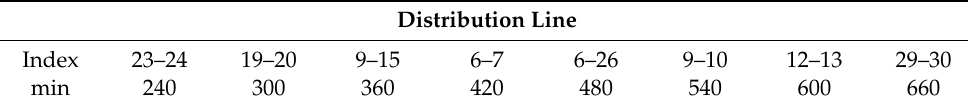
Figure 4. The situation of damaged lines for the test system. Table 1. Restored time of damage equipment [25].